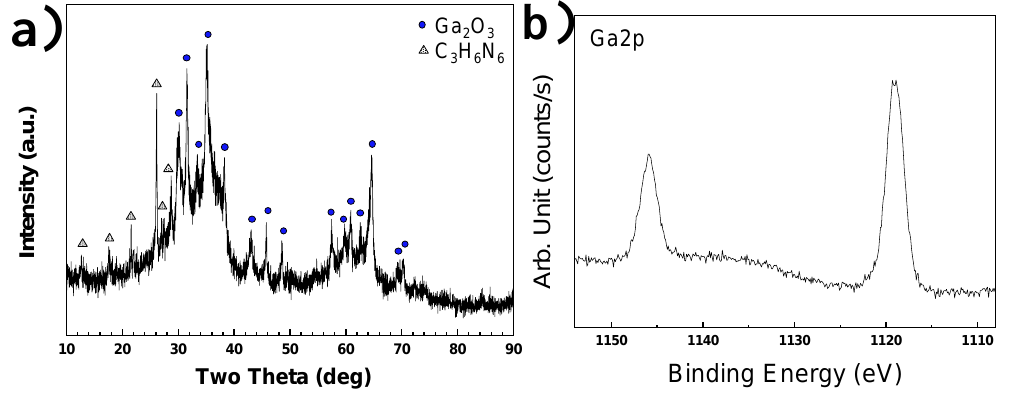
Figure 12. ( a ) XRD patterns and ( b ) XPS analysis of products synthesized from a Ga(NO 3 ) 3 ∙32H 2 O pellet and C 3 H 6 N 6 powder injection without NH 3 gas by the thermal plasma process in Plasma 5.